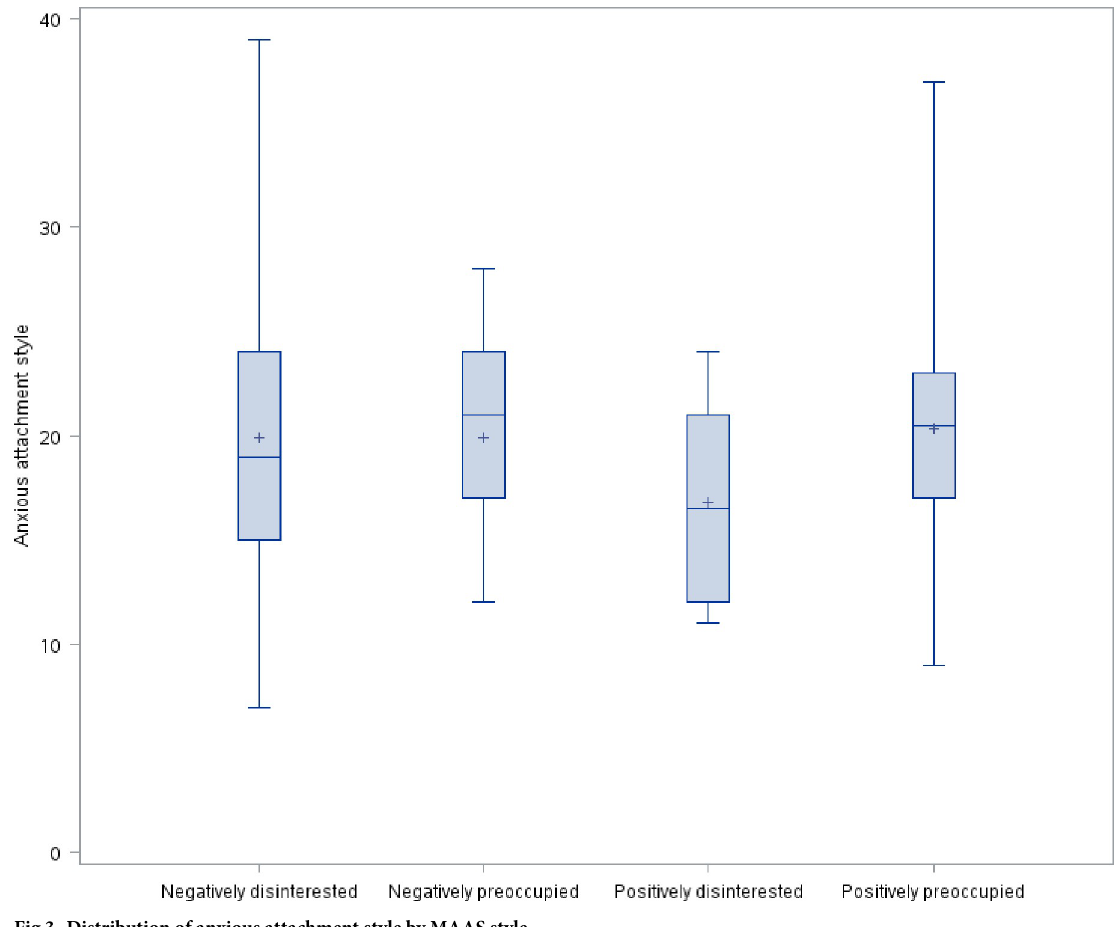
Fig 3. Distribution of anxious attachment style by MAAS